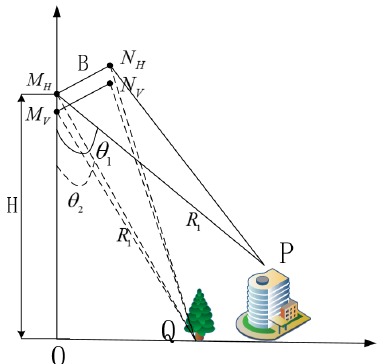
Figure 2. The schematic diagram of InSAR with different polarization modes.